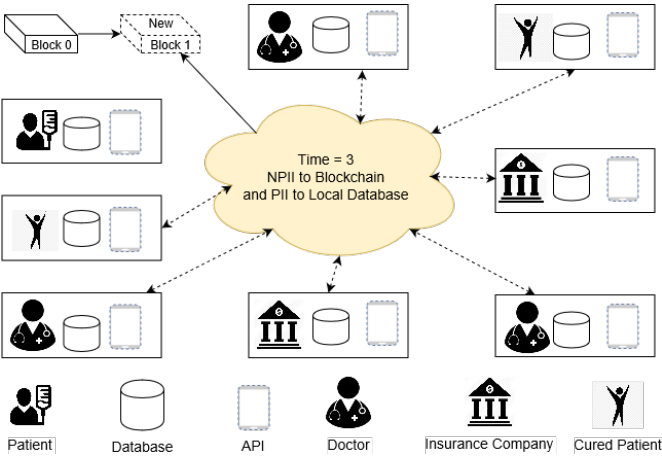
Figure 11. At time 3: Information storing in local and blockchain (new block created) databases. Appl. Sci. 2019 , 9 , x